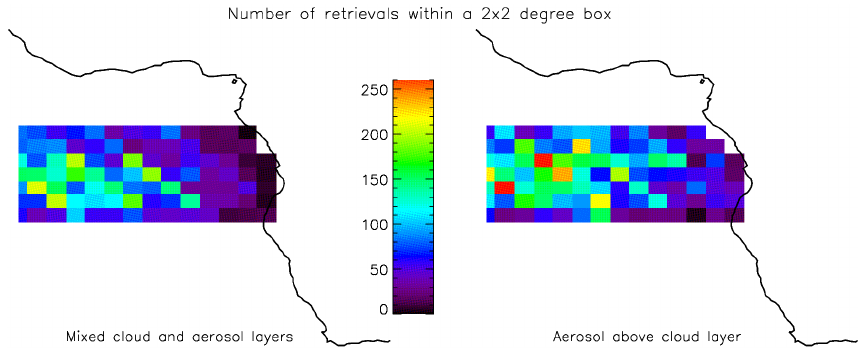
Fig. 13. Number concentration of coincident MODIS-CALIPSO retrievals for all aerosol regimes, in the region within [2S–15S; 14W–18E]. Colour scale represents number of measurements within a 2 × 2 degree box, for cases of mixed (left image) and well separated (right image) cloud-aerosol layers.